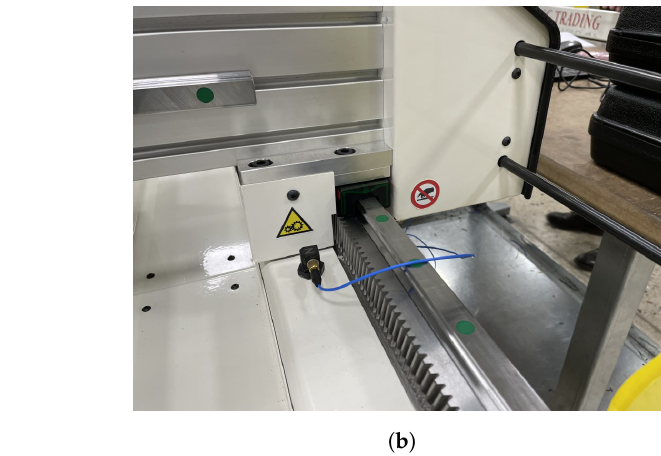
Figure 5. Experimental setup on the machine. Measurement point: ( a ) on the tool, ( b ) on the rail.